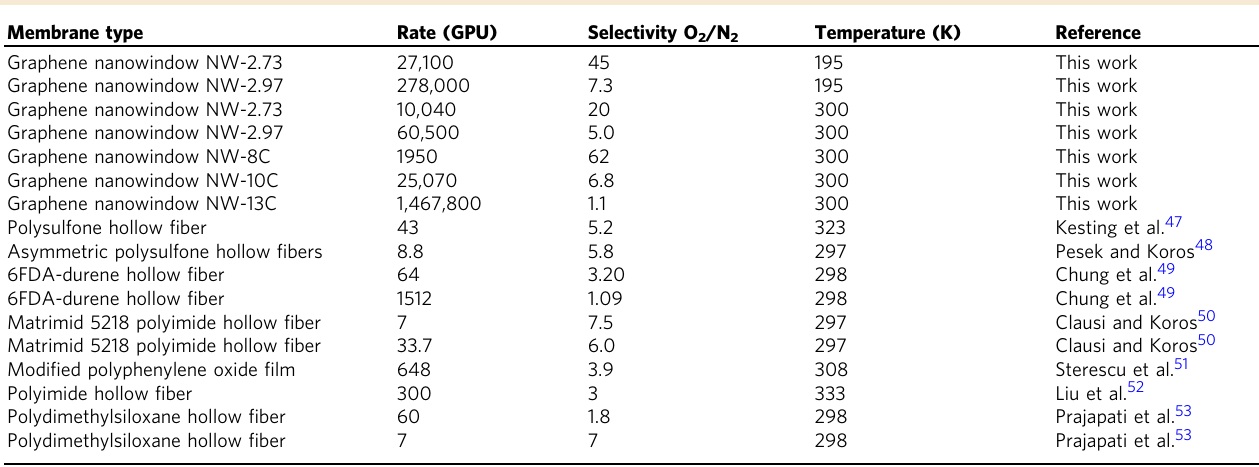
Table 1 Nanowindows separate air much faster than conventional